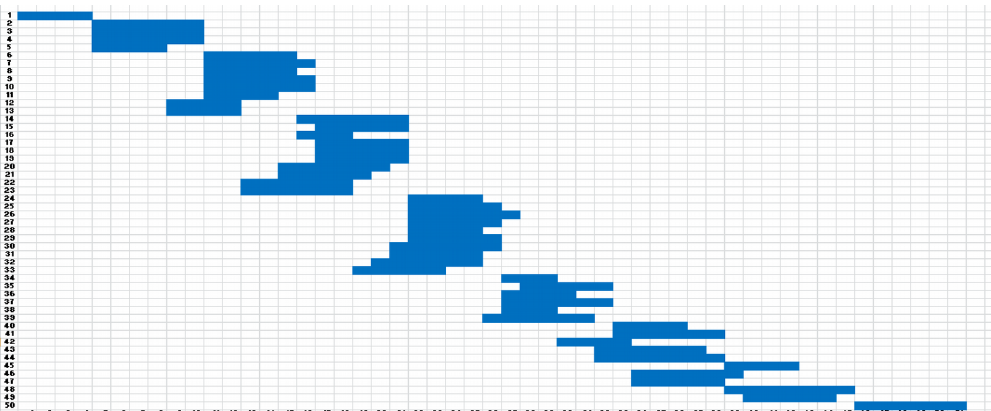
Figure 34. Gantt chart of the 10th experiment relaxed resource constraints